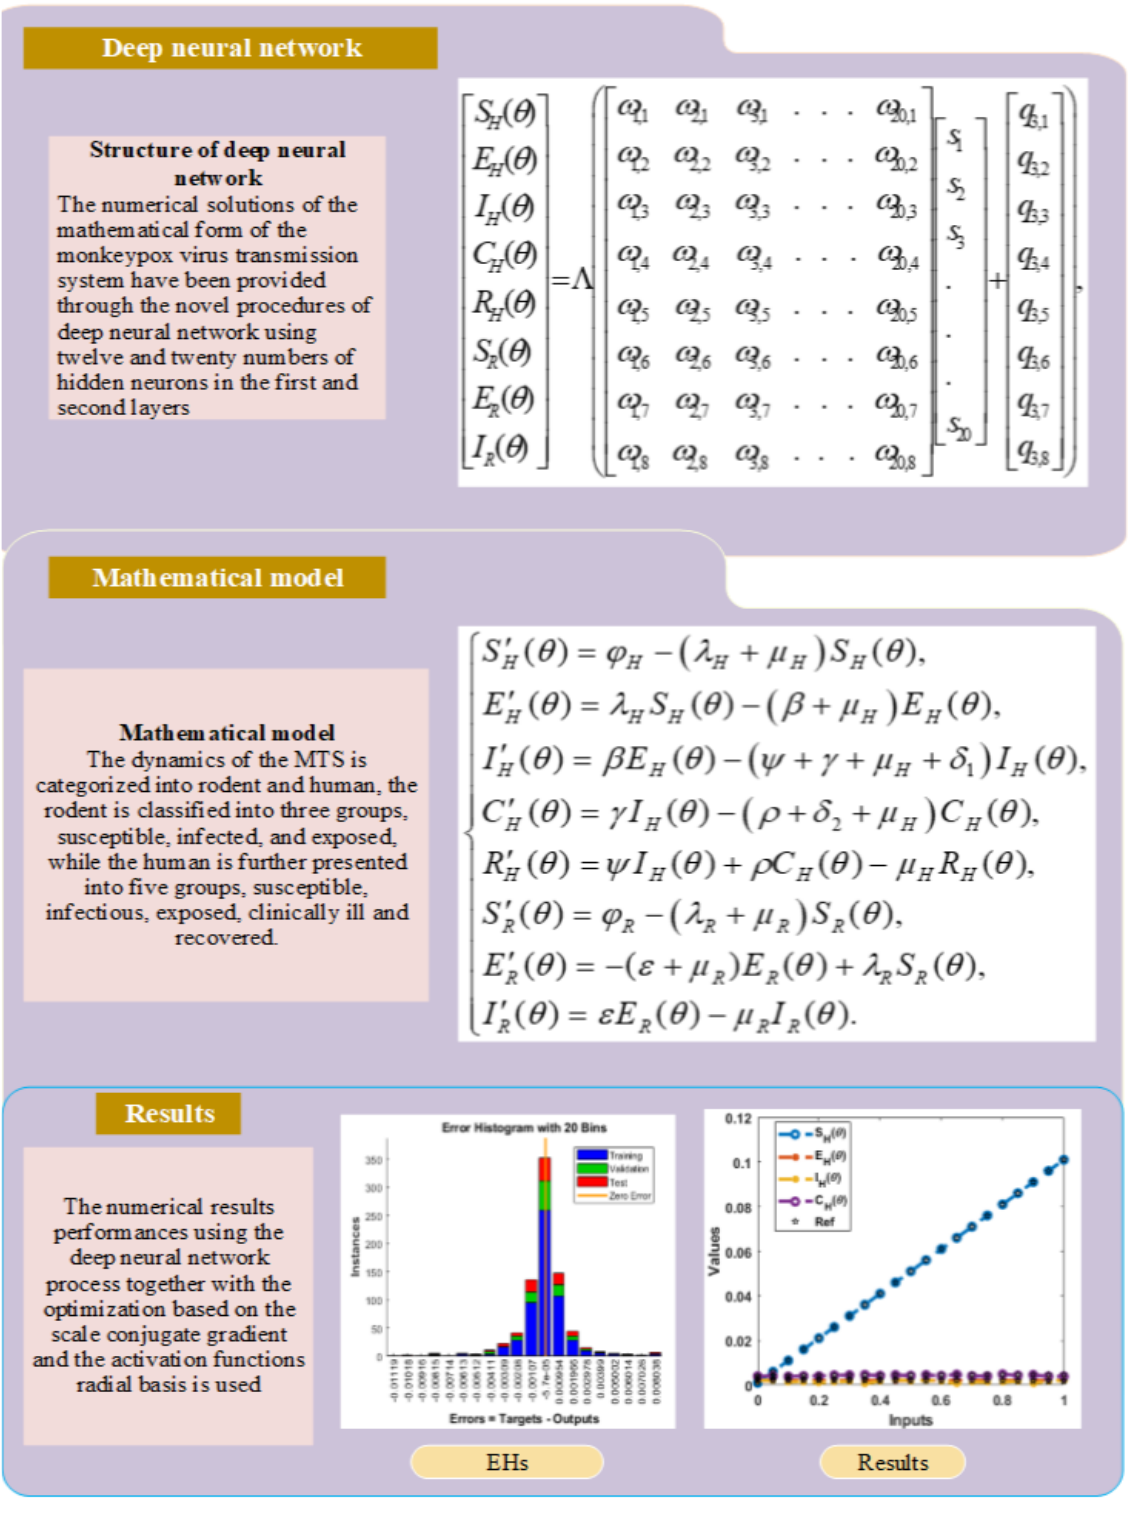
Figure 1. A deep neural network process, mathematical formulations, and assessment of outcomes for the MTS.